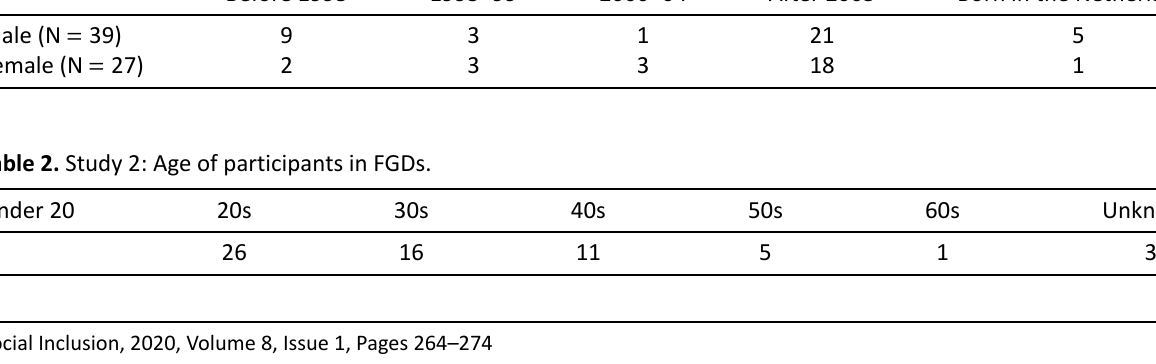
Table 1. Study 1: Participants in FGDs according to gender and year of arrival in the Netherlands. Before 1995